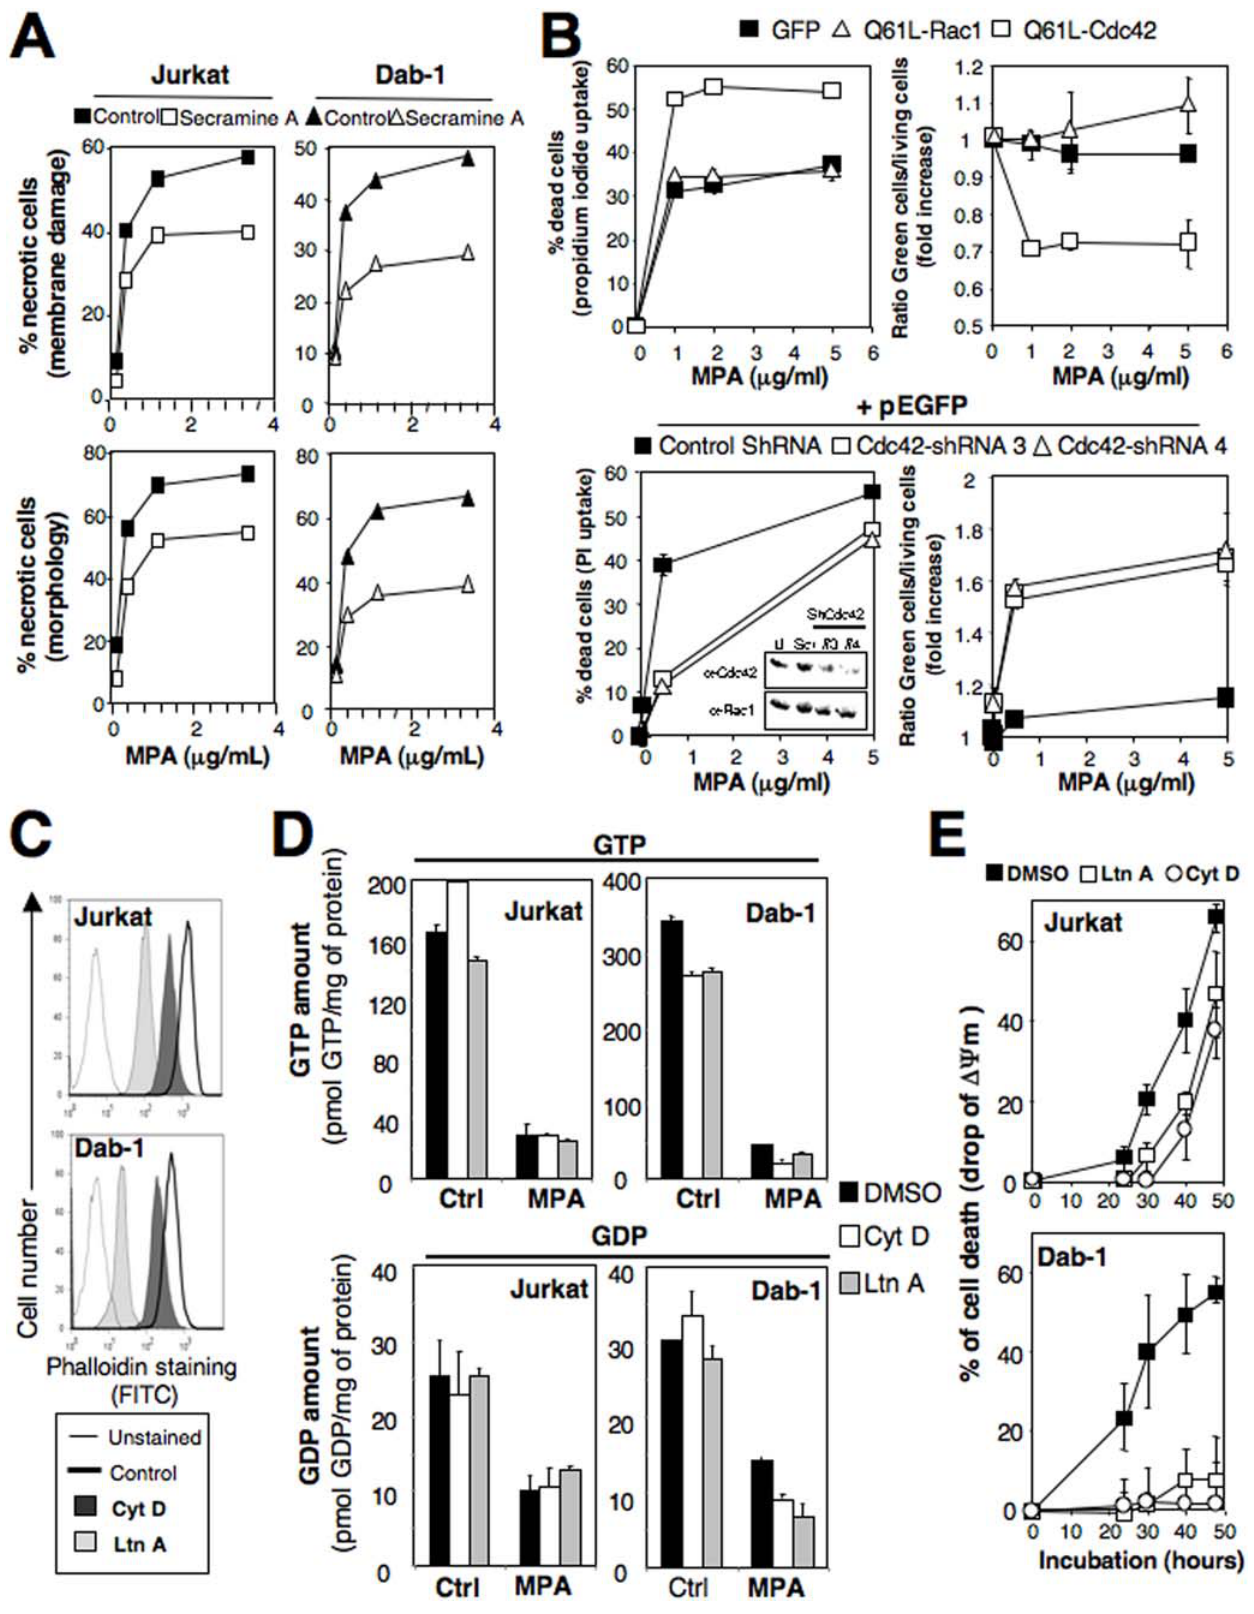
Figure 2. Cdc42 and actin are implicated in the MPA-mediated necrotic signal. (A) Cells were pre-incubated with secramine A (40 m M) or DMSO for 1 hour and then incubated for 44 hours with MPA. Necrosis was quantified by assessing the loss of the plasma membrane integrity (entry of propidium iodide) and the cell morphology. (B) Upper panel: Jurkat cells transfected with plasmid encoding Q61L-Cdc42-GFP, Q61L-Rac1-GFP or